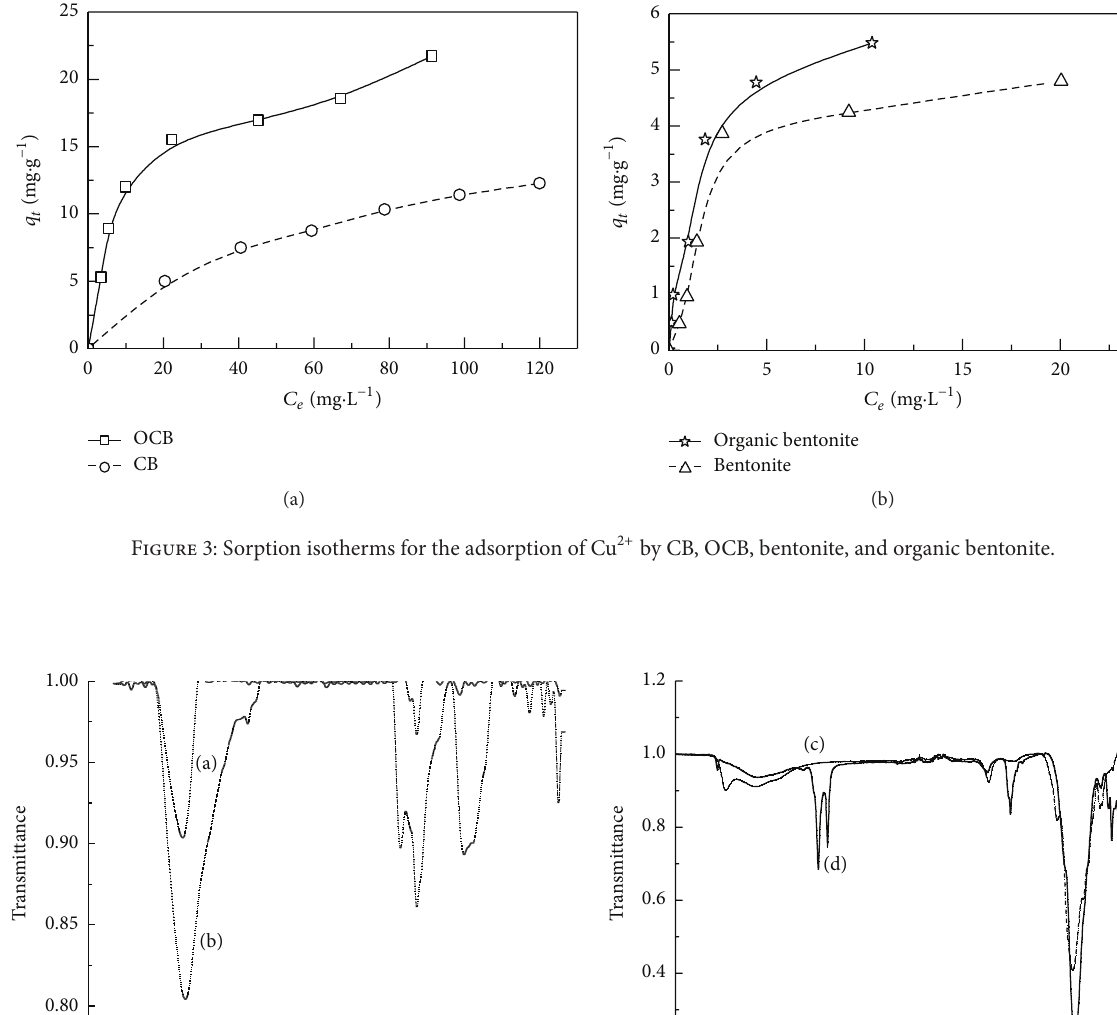
the CNO bending vibration. All these oxygen-containing functional groups chelating with heavy metal ion were absent in